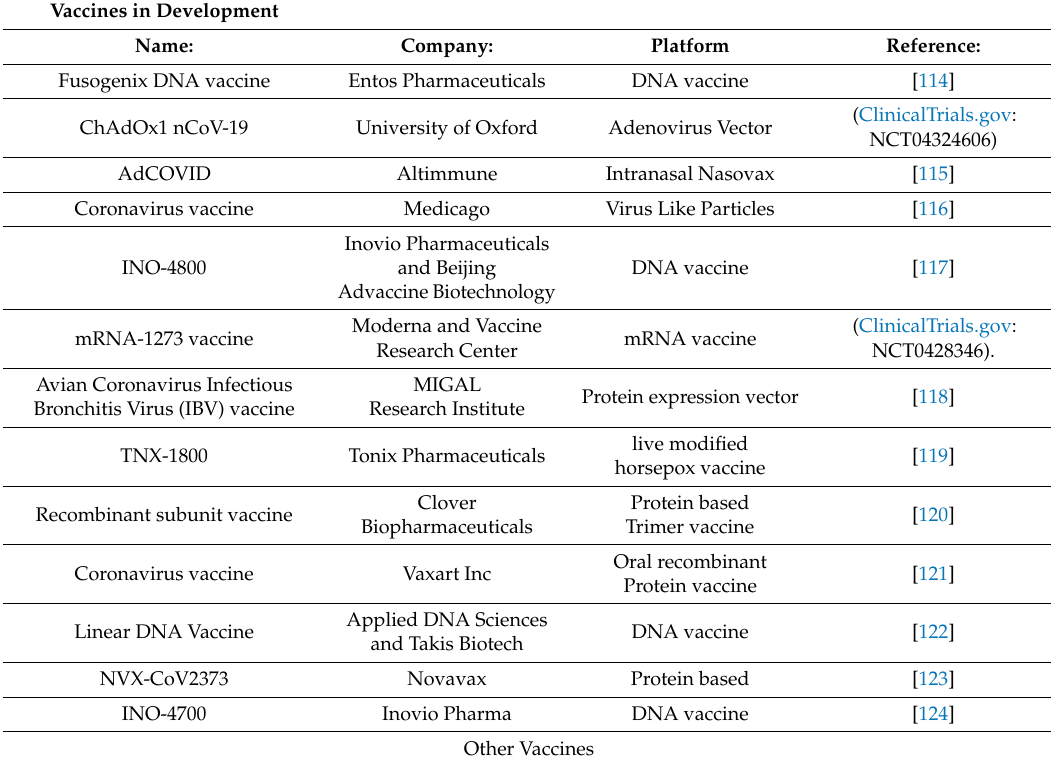
Table 3. A list of vaccines in development for